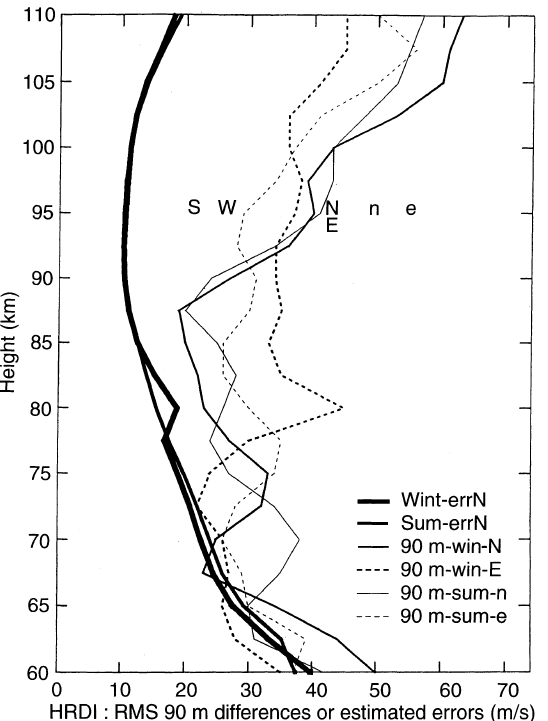
Fig. 6. HRDI RMS 90 min di(cid:128)erences ( (cid:68) D < 1000 km) for north and east components, winter (Nov.–Feb.) (labelled 90 m-win-N and 90 m-win-E ), and summer (May–Aug.) (labelled 90 m-sum-N and 90 m-sum-E ), and RMS estimated errors, scaled up by and summer north component: wint-errN and sum-errN . Night-times (95 km) are shown by characters as follows: N , E represent winter, and n , e summer, 90 min di(cid:128)erences, while S and W are summer and winter estimated errors, All HRDI data shown in this figure are from